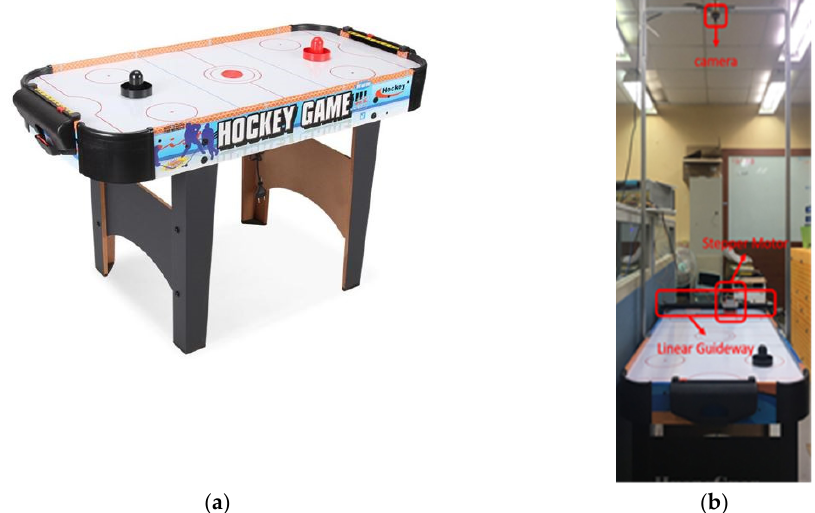
Figure 1. ( a ) Full picture of an air hockey table. ( b ) The air hockey table is set up with a stepper motor, a linear guideway, and a camera